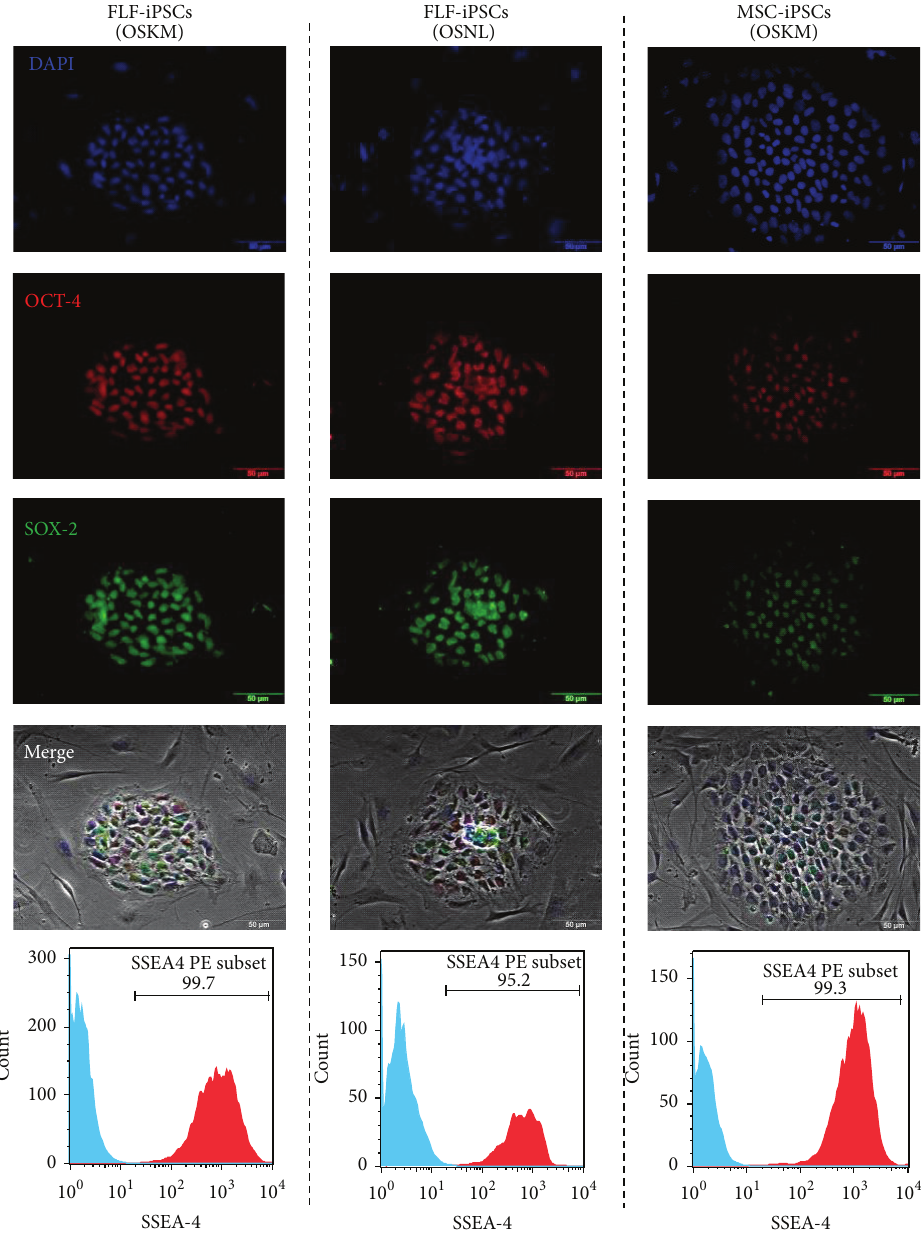
Figure 1: Generation and characterization iPS cells from human fetal liver fibroblasts (FLF) with Oct4, Sox2, Klf4, and c-Myc (OSKM) and Oct4, Sox2, Nanog, and Lin-28 (OSNL) and also from human bone marrow MSCs with OSKM using lentiviral vectors. iPSCs stained positive